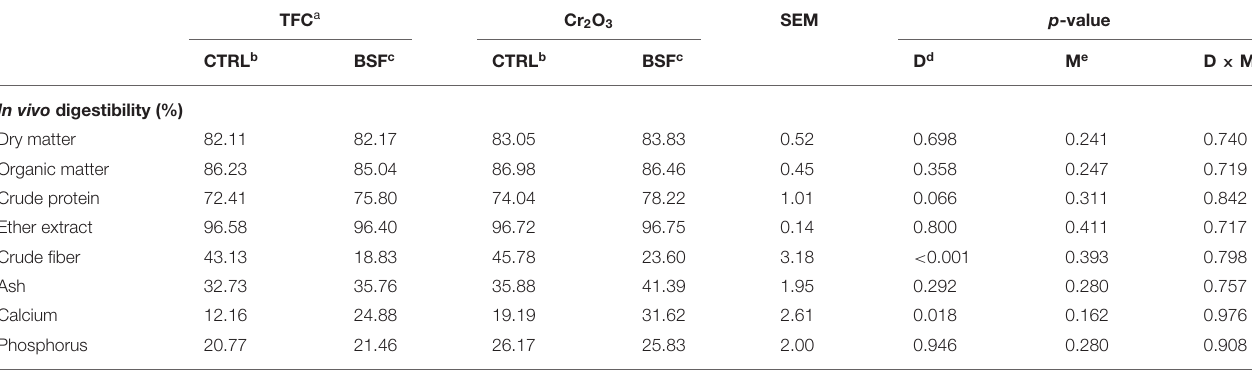
TABLE 2 | Comparison of the in vivo digestibility using the total fecal collection method (TFC) and in vivo digestibility with marker (Cr 2 O 3 ) in six dogs (mean values are presented). TFC a